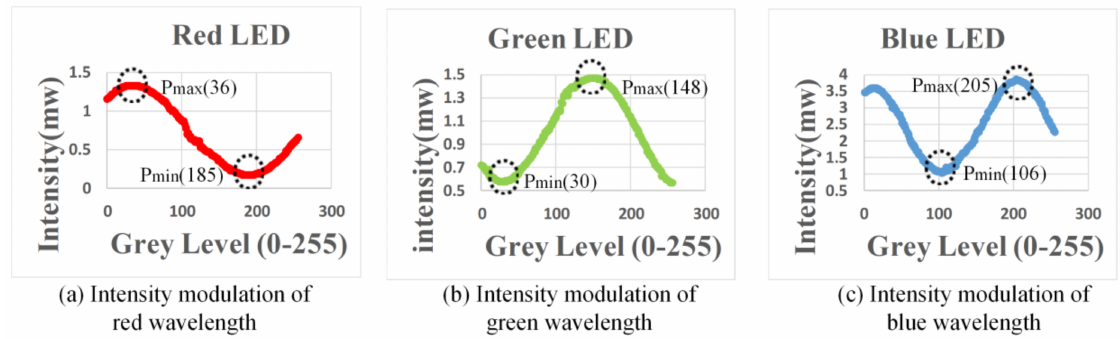
Figure 4. Calibration results of LCoS-based SLM using